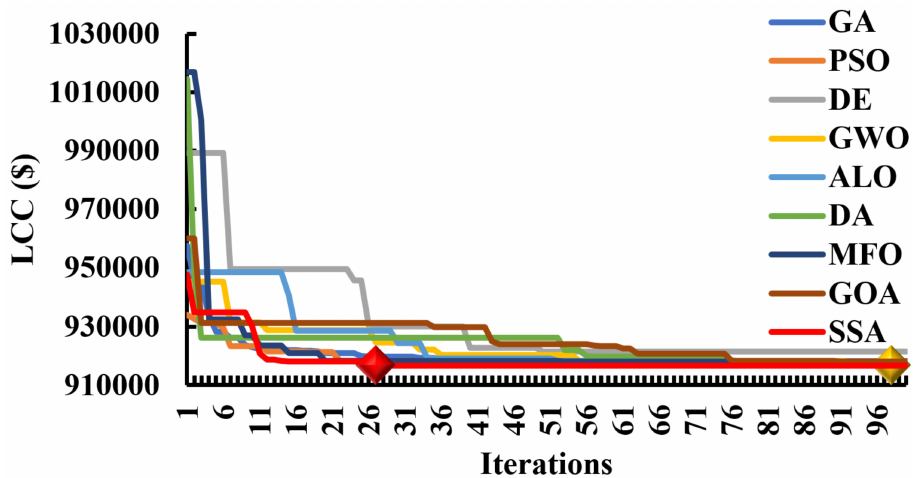
Figure 18. Convergence curves of the Ni-Fe battery-based IHRES with LF strategy using HPRALC- based scenario.